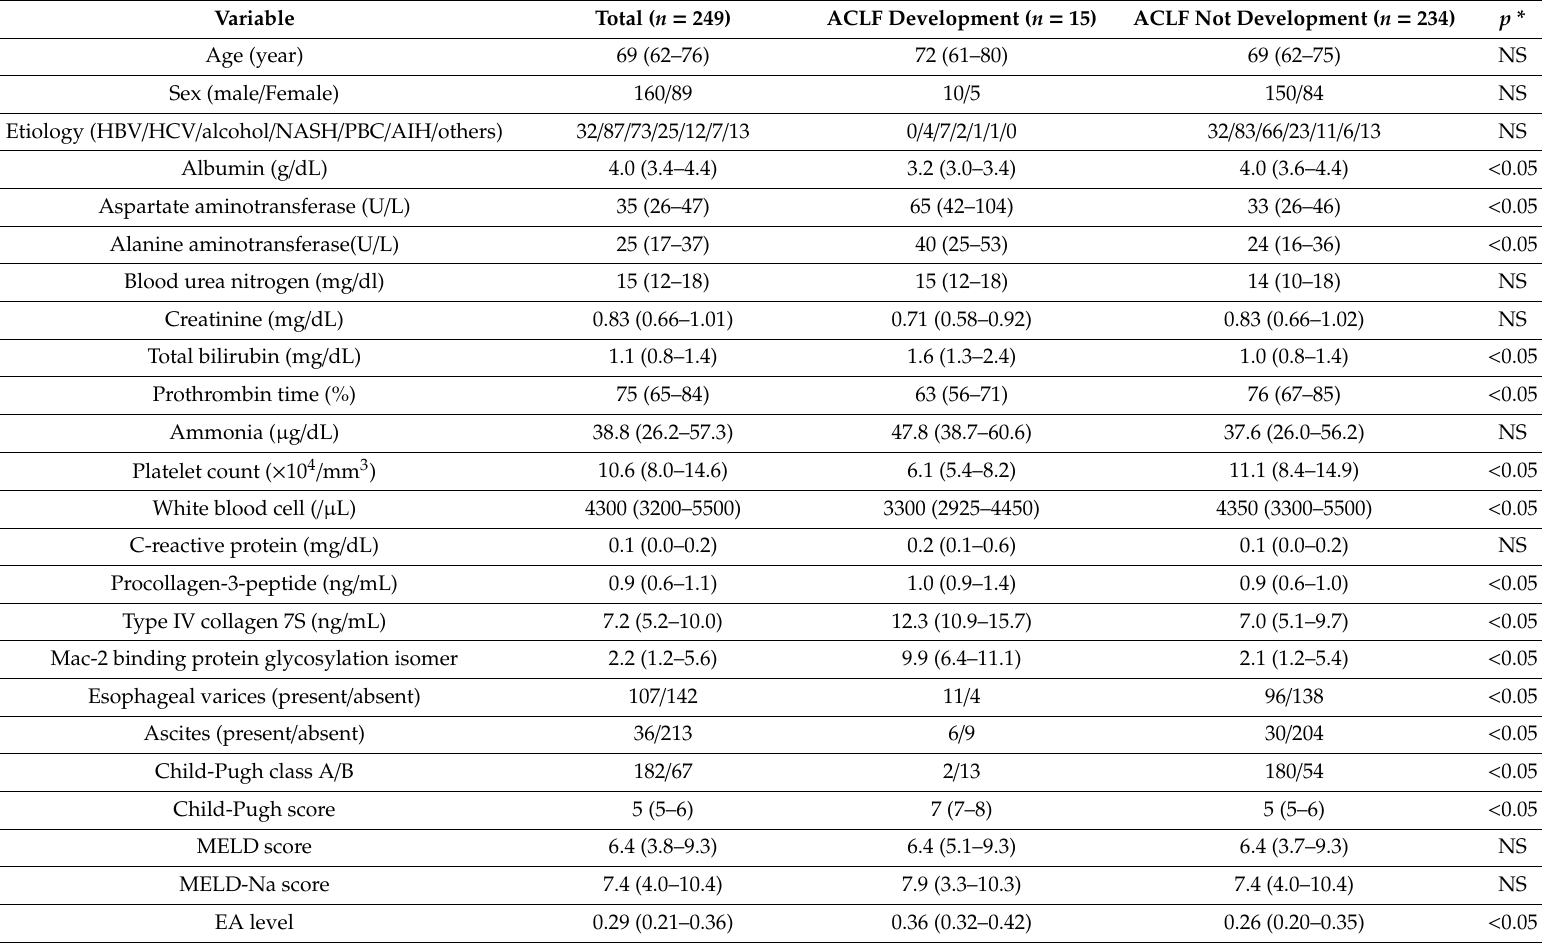
Table 1. Characteristics of patients with and without ACLF